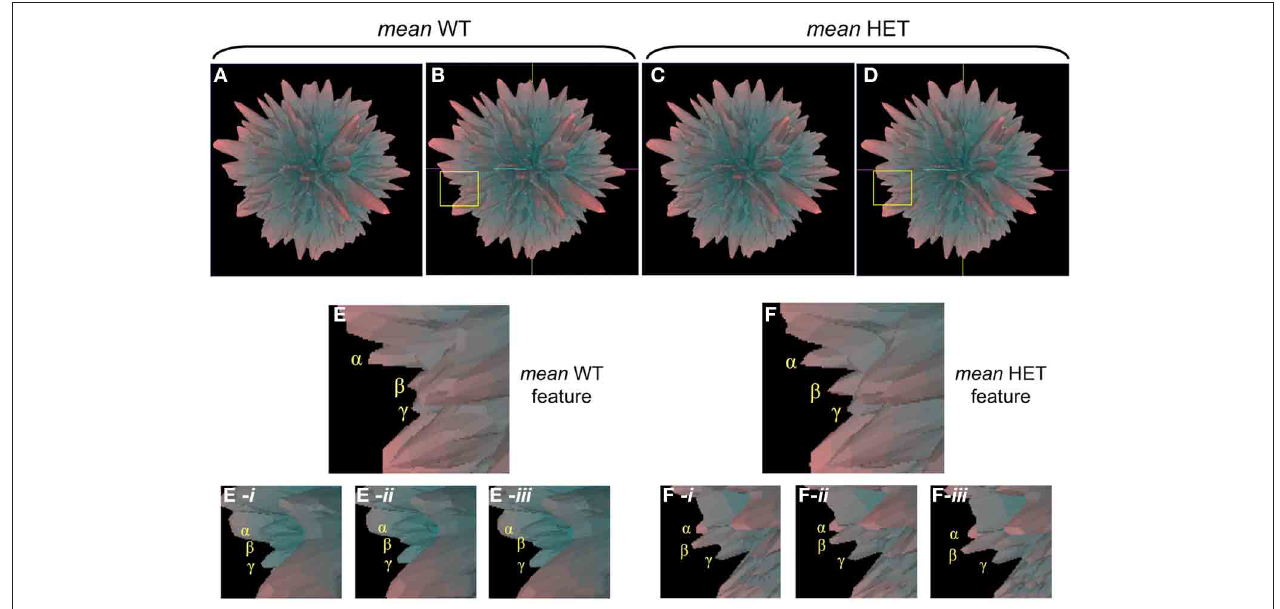
FIGURE 4 | Individual plurigon basis for structural variation in mean plurigon structures. (A) Mean WT ( B -coordinate location version) and mean HET ( C,D -coordinate location version) are depicted with a region of structural diversity between them highlighted in the yellow inset box ( B -WT, D -HET). Panels (E) and (F) indicate these expanded regions from the yellow inset boxes in (B) and (D) . The three projecting features creating the structural